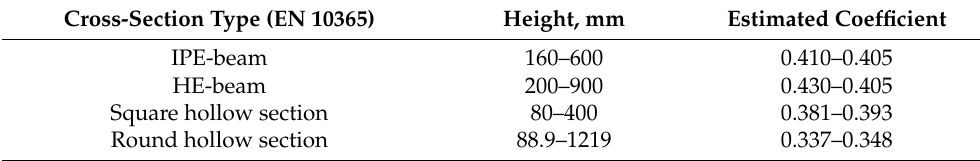
Table 1. Approximated values of the shape coefficient α c